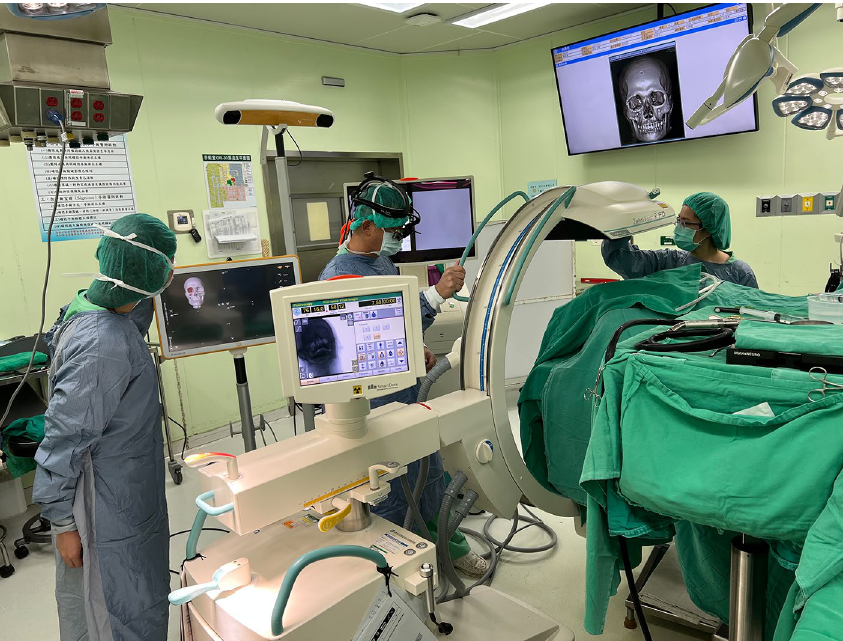
Figure 4. The setup of surgical navigation and intraoperative 3D C-arm computed tomography. The surgical navigation was used as a guide to determine the implant position. After plating, intraoperative 3D C-arm CT was performed to examine the adequacy of zygoma reduction and orbital